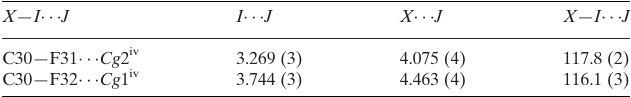
C—F (cid:2)(cid:2)(cid:2) (cid:3) interactions (A˚ , (cid:4) ). Cg 1 and Cg 2 are the centroids of the C9/N10/C11–C14 and C1–C4/C11/C12 rings, respectively.